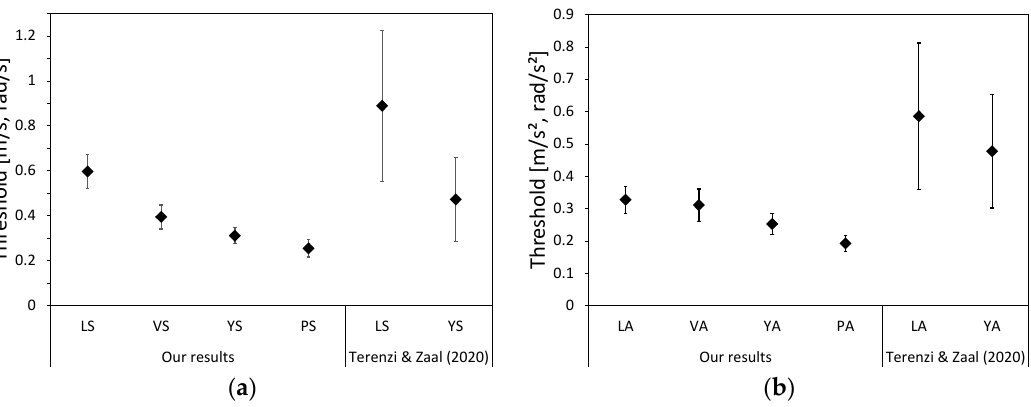
Figure 2. Averages of threshold for this study and Terenzi and Zaal [18]: ( a ) the constant velocity; ( b ) the constant acceleration. The error bars represent 95% confidence intervals for each condition.